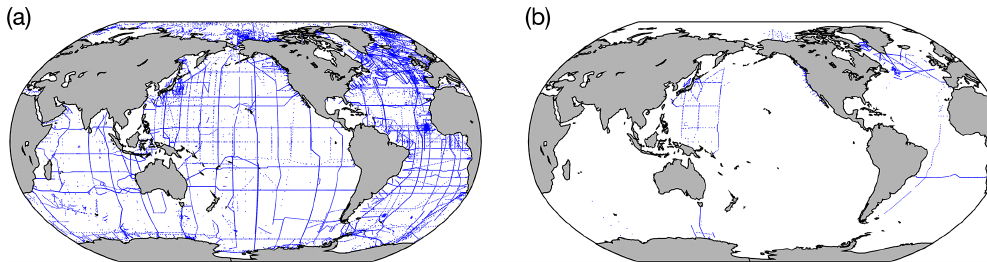
Figure 1. Location of stations in (a) GLODAPv2.2019 and for (b) the new data added in this update.